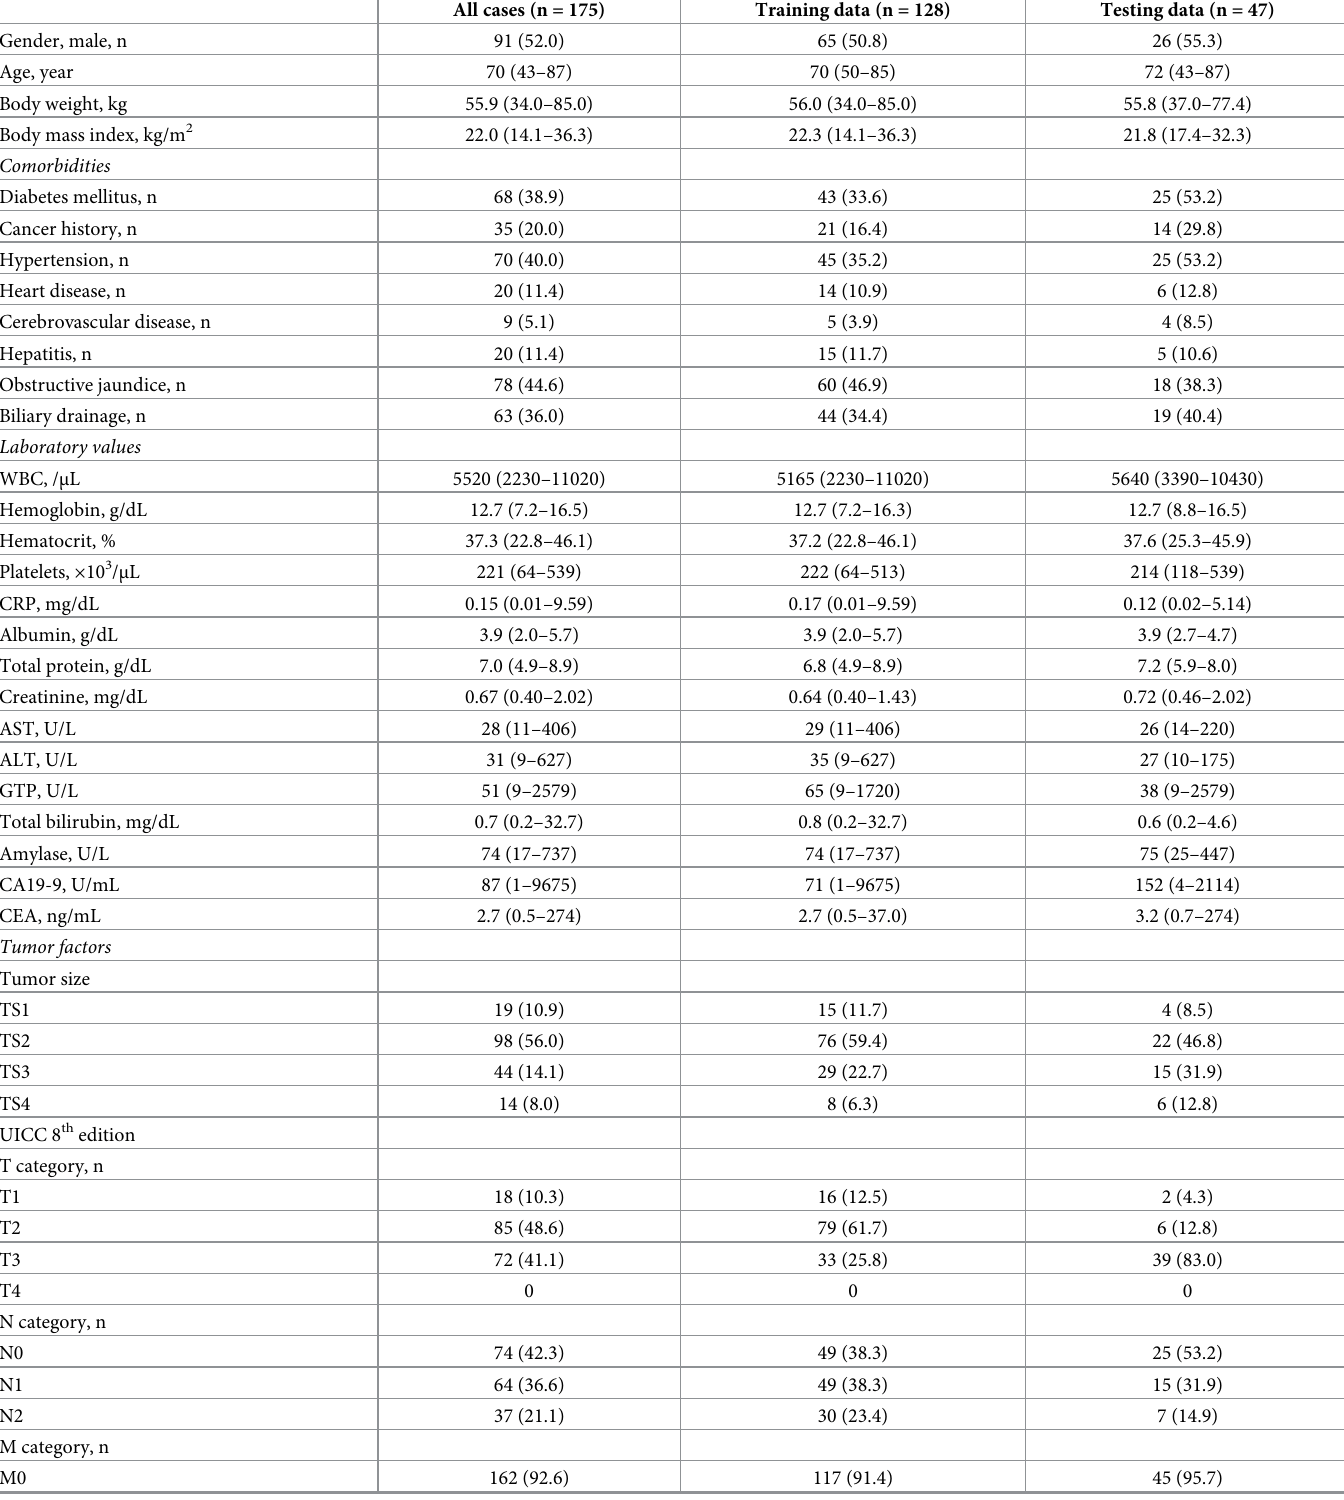
Table 1. Patient characteristics in data